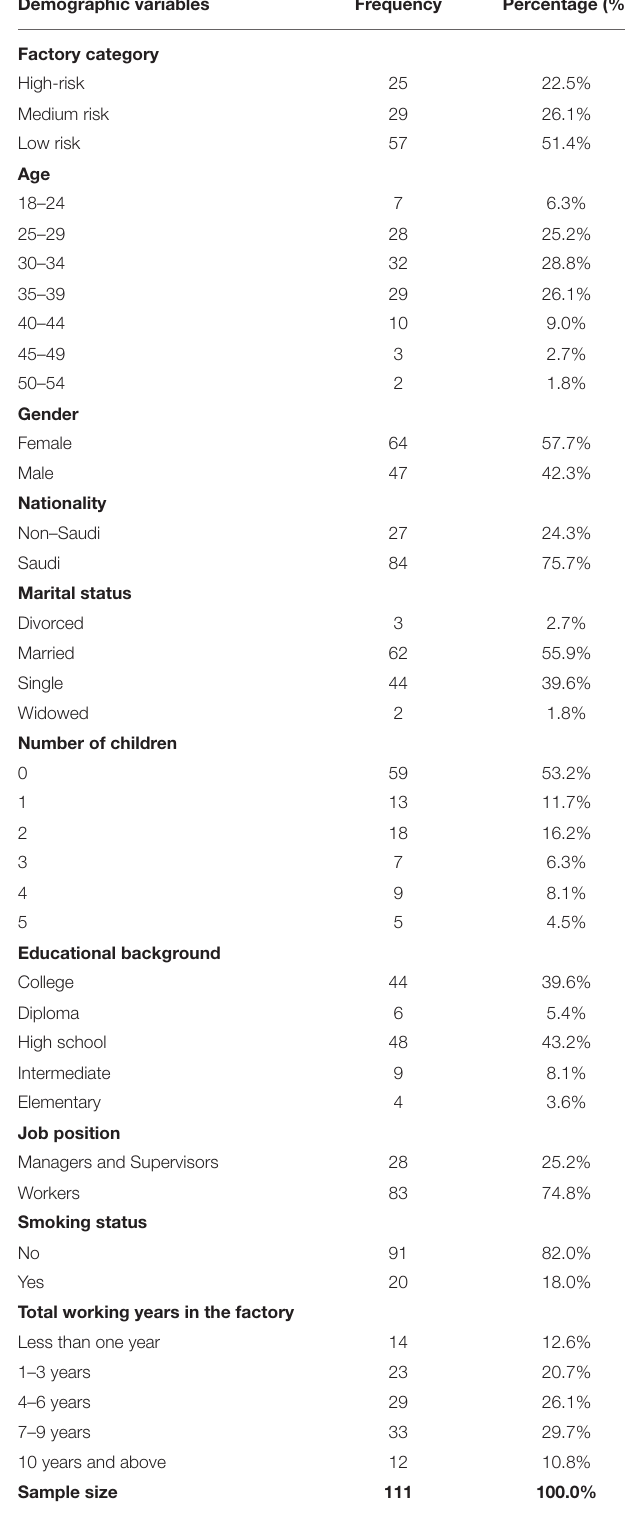
TABLE 2 | Descriptive analysis of the demographics